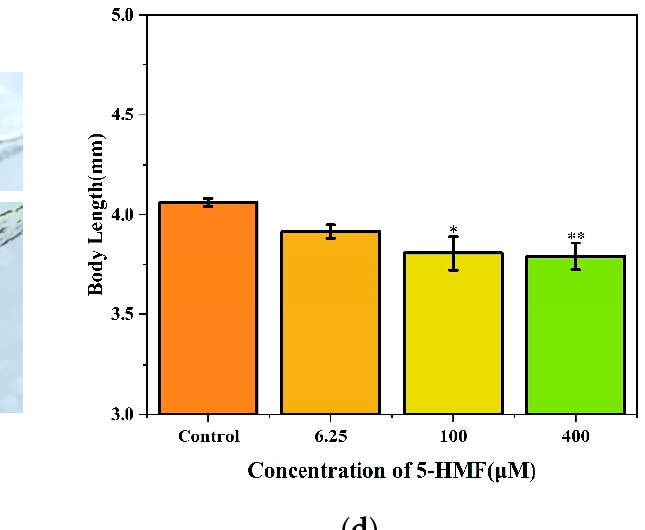
( d ) Figure 3. Effect of different concentrations of milk powder matrix incubation for 120 h on zebrafish larvae. ( a ) Survival rate of zebrafish embryos cultured with different concentrations of milk powder matrix; ( b ) Hatching rate of zebrafish embryos cultured with different concentrations of milk pow- der matrix; ( c ) Development of zebrafish larvae cultured with low concentration milk powder ma- trix; ( d ) Body length of zebrafish larvae cultured with low concentration of milk powder matrix. Abbreviations: Milk, milk powder matrix. *** p < 0.001 vs. control. 3.4. Determination of Oxidation Parameters Zebrafish embryos were exposed to 5-HMF for 120 h. In standard water, the two high-concentration groups (20 μ M and 200 μ M) resulted in shortened body lengths of zebrafish larvae in a concentration-dependent manner. However, in the milk powder ma- trix, only one group with a concentration of 200 μ M resulted in the shortest body lengths (Figure 4a). In the two matrices of standard water and milk powder, the concentration of MDA in zebrafish larvae was slightly lower than that of the control group when they were exposed to 2 μ M and 20 μ M 5-HMF, while it was higher than that of the control group with the concentration of 5-HMF at 200 μ M. In general, the concentration of MDA in zebrafish larvae exposed to 5-HMF in milk powder matrix was higher than that in stand- ard water (Figure 4b). The concentration of GSH was significantly lower in both matrices when concentration of 5-HMF was 200 μ M, and the changes in GSH at 2 μ M and 20 μ M groups were not significantly different (Figure 4c). In standard water, SOD activity was significantly increased at 2 μ M group, and it was no significant difference in the elevated 20 μ M and 200 μ M groups. In the milk powder matrix, SOD activity gradually enhanced with increasing concentrations, all of which were significantly different (Figure 4d).